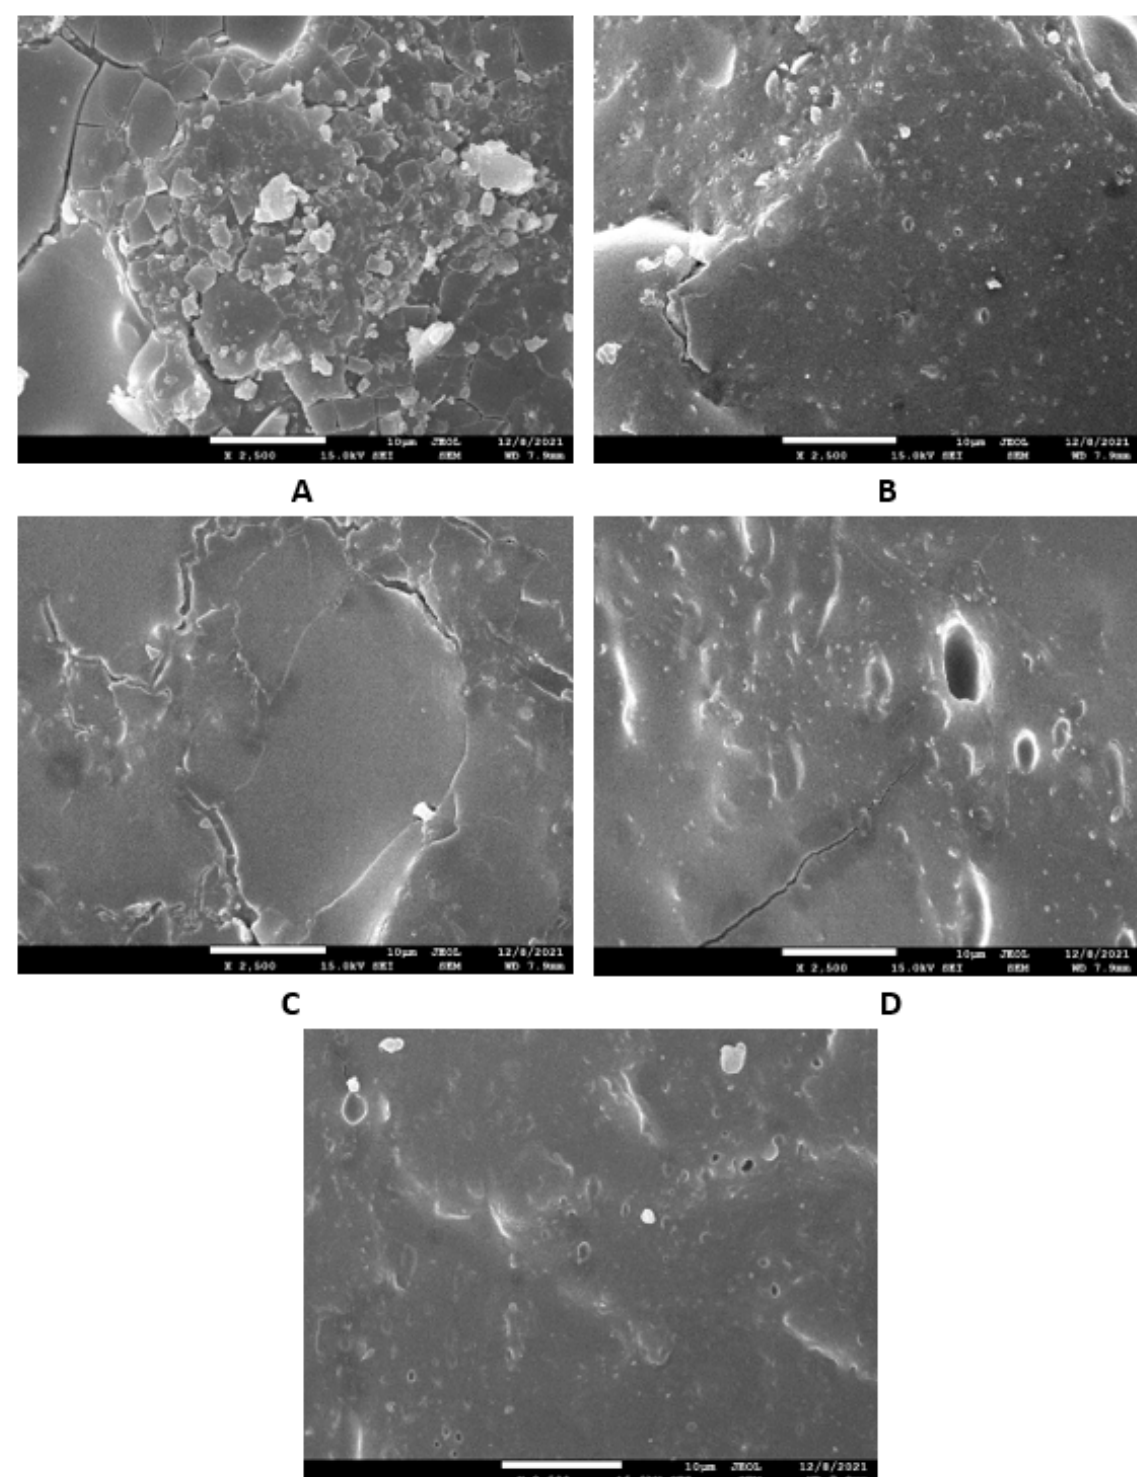
Figure 16. SEM images of vulcanizates based on NBR: ( A ) reference vulcanizate without glycerol, ( B ) vulcanizate with 5 phr of glycerol, ( C ) vulcanizate with 10 phr of glycerol, ( D ) vulcanizate with 15 phr of glycerol, and ( E ) vulcanizate with 20 phr of glycerol.